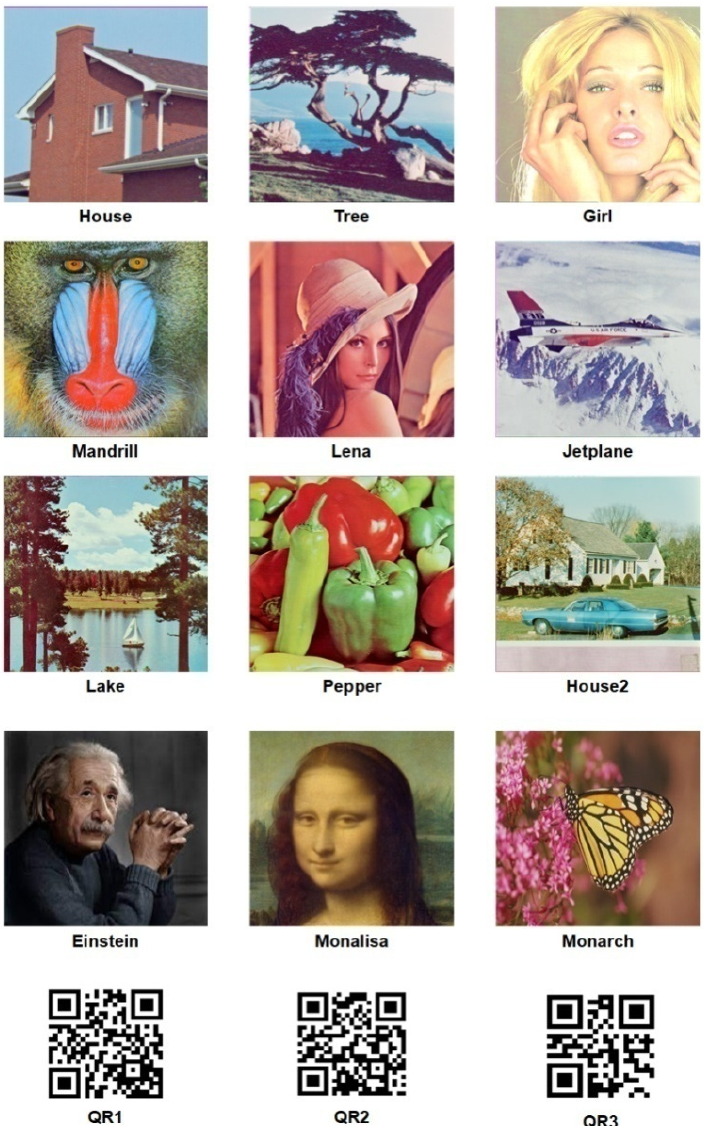
Figure 6. Sample color image.